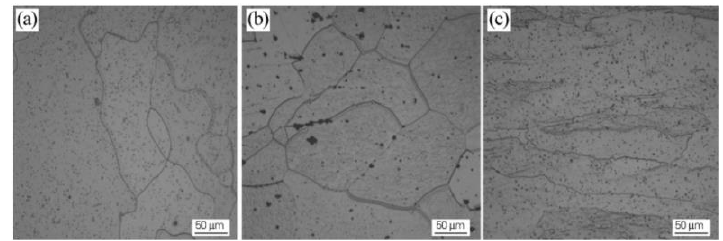
Figure 5. Microstructure of weld joint ( a ) welding seam zone, ( b ) heat-affected zone, and ( c ) TZM martix. [24].